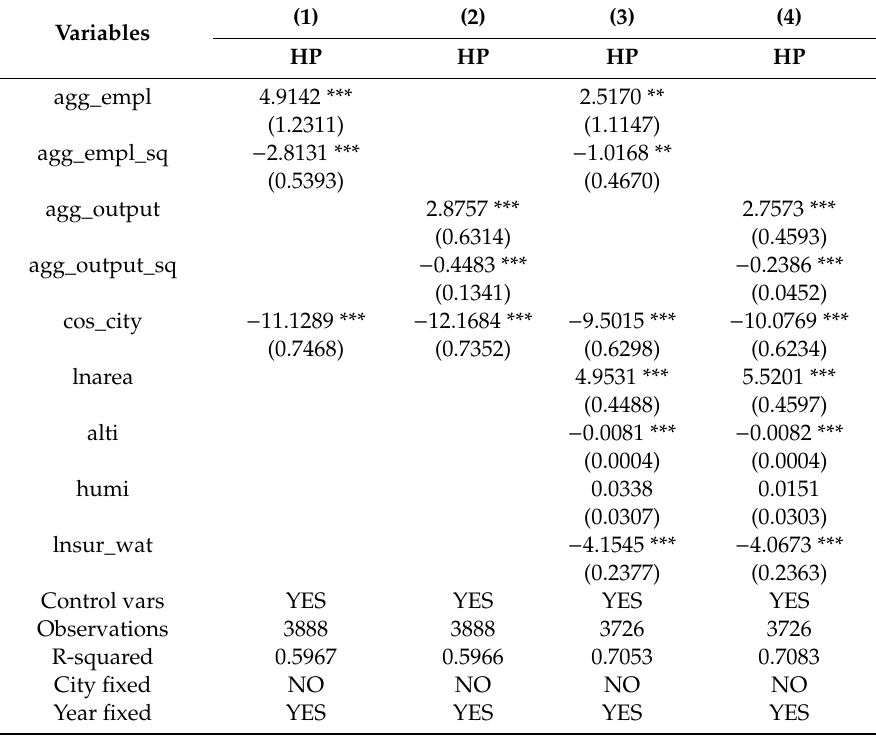
Table A3. Control for costal and comprehensive